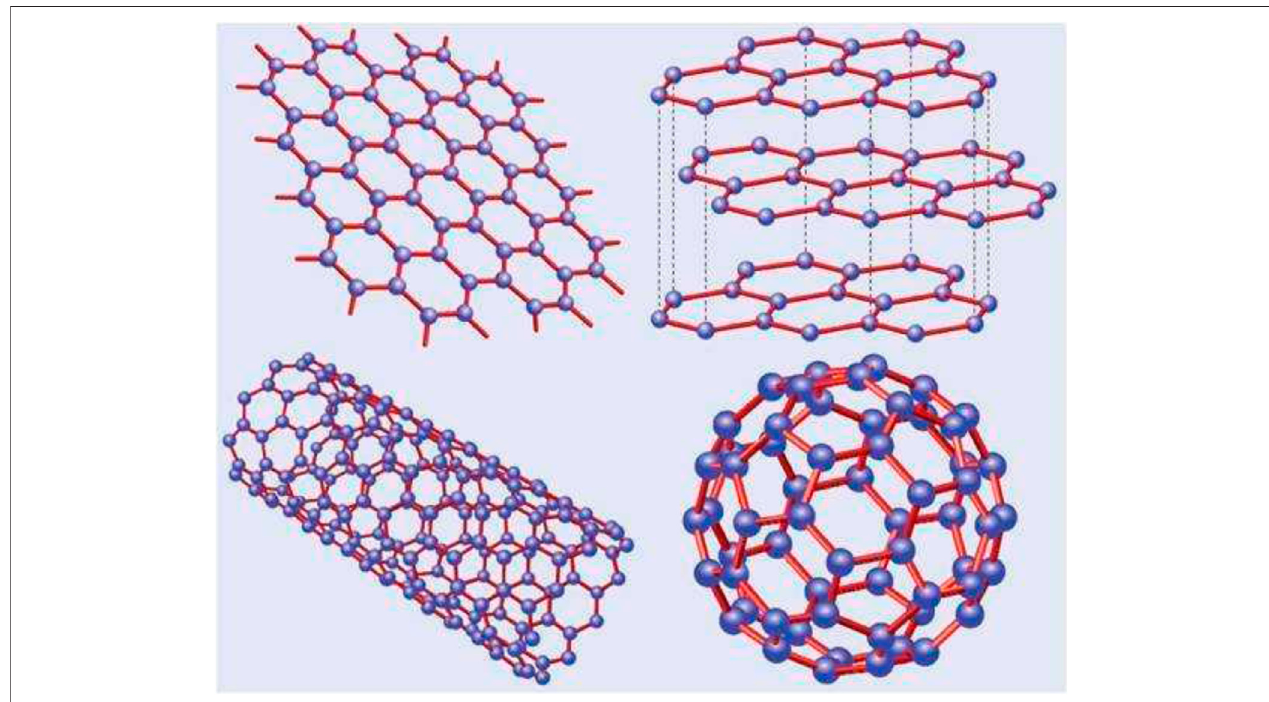
FIGURE 1 | Basic structure of graphene (YARRIS et al., 2007).